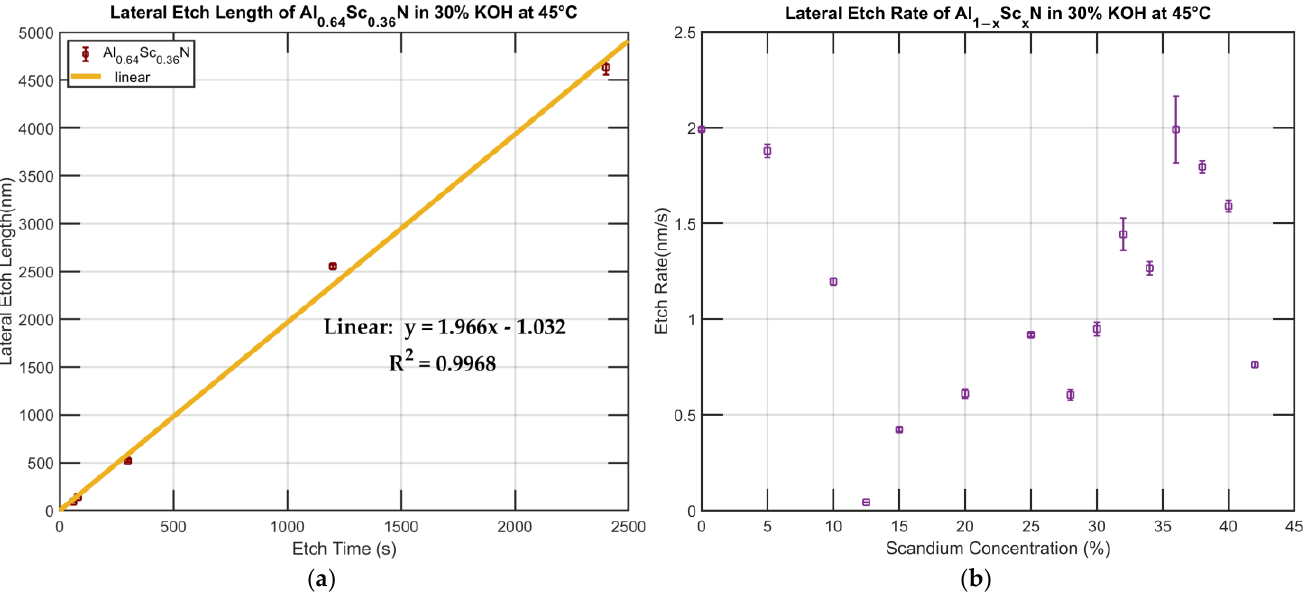
Figure 6. ( a ) . Lateral etch length with respect to etch time of Al 0.64 Sc 0.36 N in 30% KOH at 45 °C. ( b ) Lateral etch rate of Al 1 − x Sc x N in 30% KOH at 45 °C (long etch time).